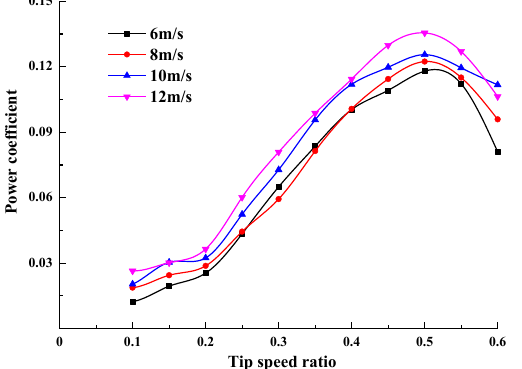
Figure 12. Output power coefficients of spiral wind turbine under various incoming wind speeds.